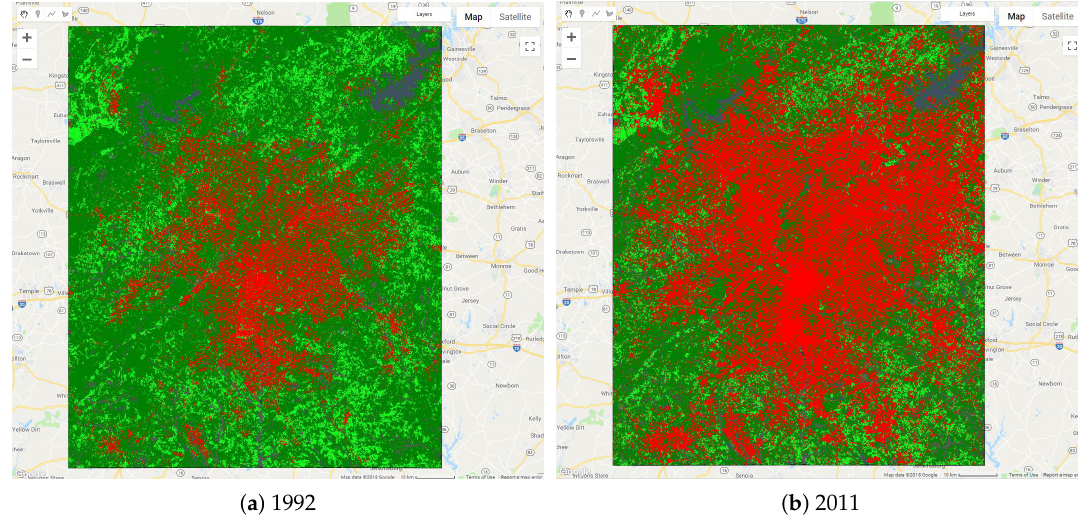
Figure 6. Atlanta MA: LC situation in 1992 ( a ) and in 2011 ( b ). In red, the Urbanized class, in light green, the Cultivated class, in dark green, the Forest and Shrubland classes.